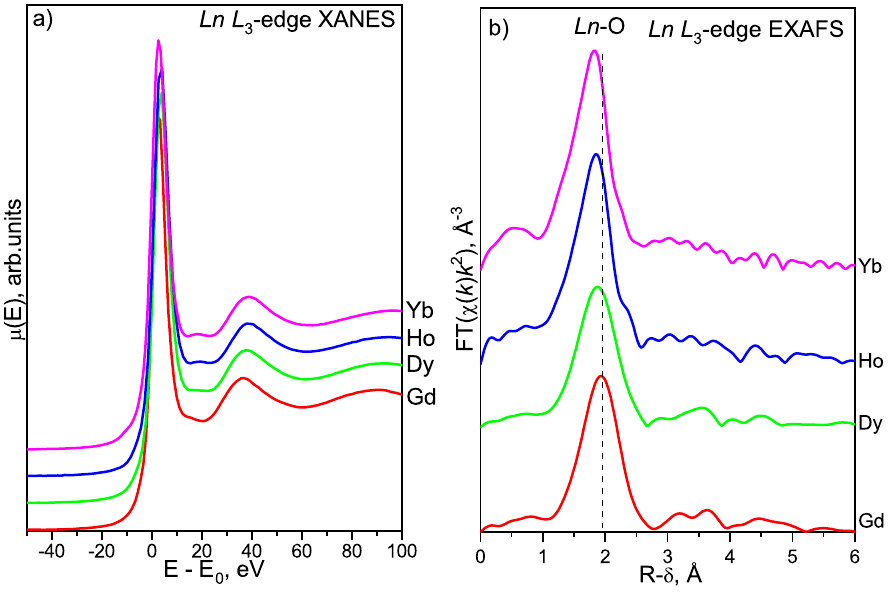
Figure 6. Ln L 3 -edge XANES spectra ( a ) and EXAFS FT moduli ( b ) of hydrated Ln WO-1000-1.5y. Ln L 3 -Edge